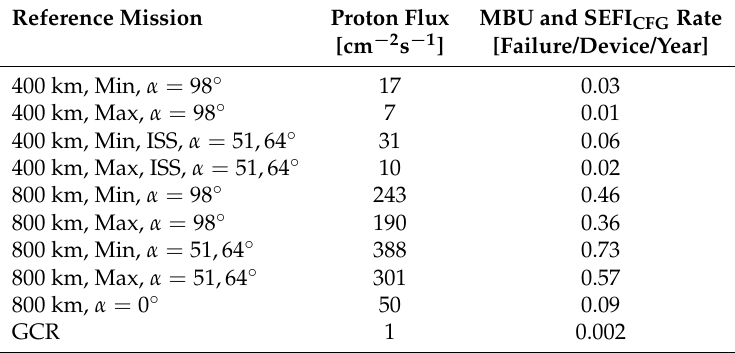
Table 14. MBU and SEFI CFG event rates for considered reference